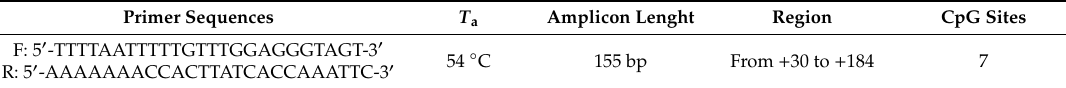
Table 3. Sequence of the primers, annealing temperature ( T a ), length of the amplicon, studied region and number of CpG